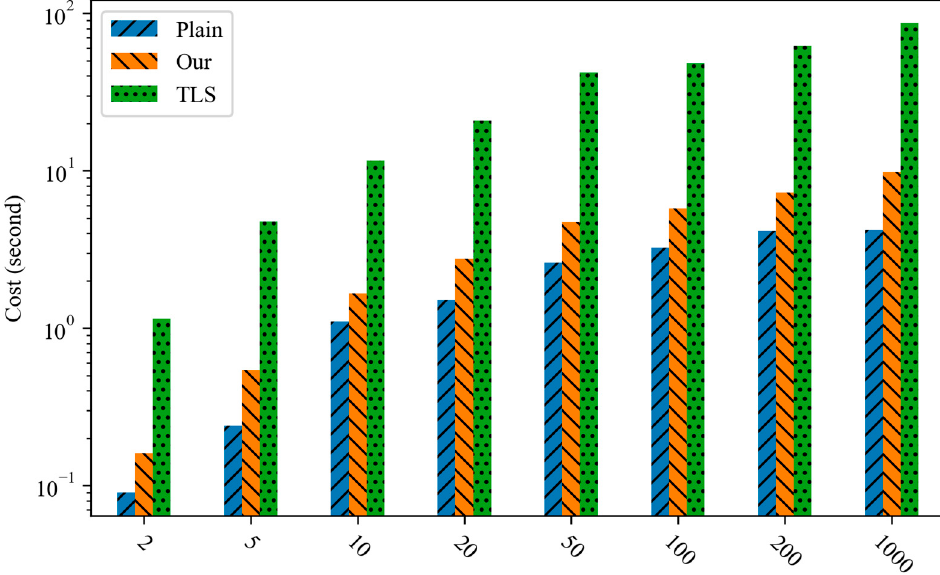
Figure 4. Comparisons of encryption latency among plain (no-encryption), our, and TLS methods. Note that the y-axis is on a logarithmic scale.